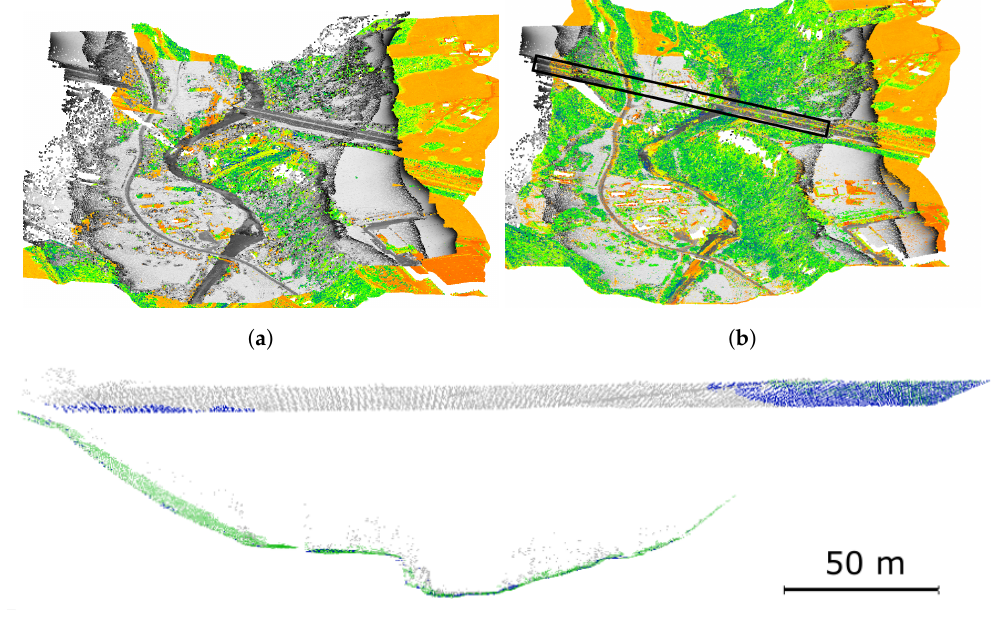
Figure 5. Result of the proposed approach shown on the second scene. ( a ) Overview of the second Scene with initial transformation. ( b ) Overview of the second Scene with registration result. ( c ) Profile view of the marked area in ( b ). Shown data are the original data of 2012 and the data of 2017 downsampled to 0.5 m GSD. The color representation is the same as in Figure